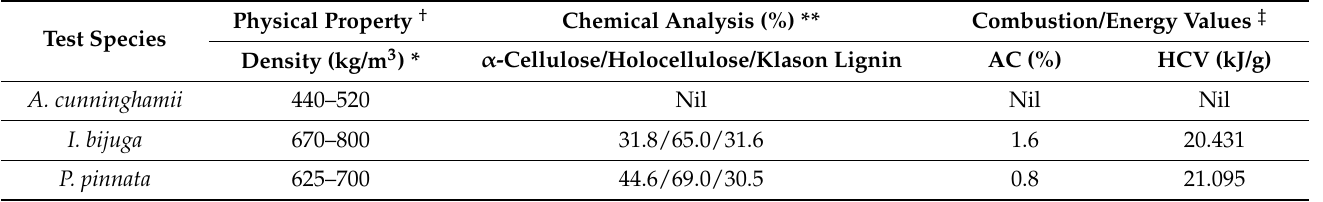
Table 1. Physical and chemical properties of test species.